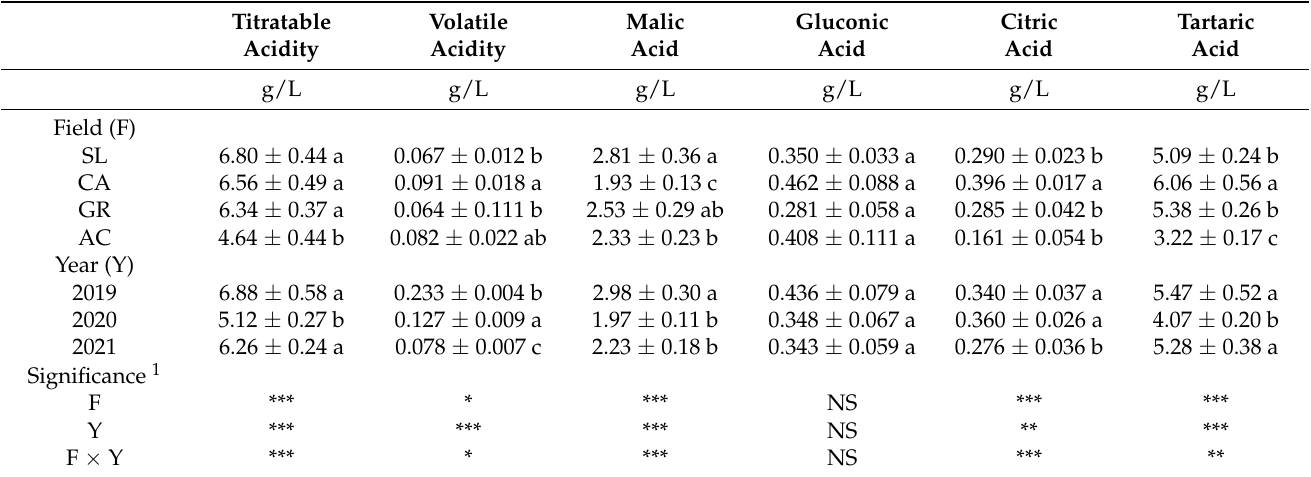
Table 5. Effects of field (F), year (Y), and their interaction (F × Y) on titratable acidity, volatile acidity, malic acid, gluconic acid, citric acid, tartaric acid of V. vinifera subsp. vinifera “Falanghina” vines at the four study sites: SL-Santa Lucia, CA-Calvese, GR-Grottole, and AC-Acquafredde. Mean values and standard errors are shown. Different letters within each column indicate significant differences according to Duncan’s multiple comparison tests ( p ≤ 0.05).